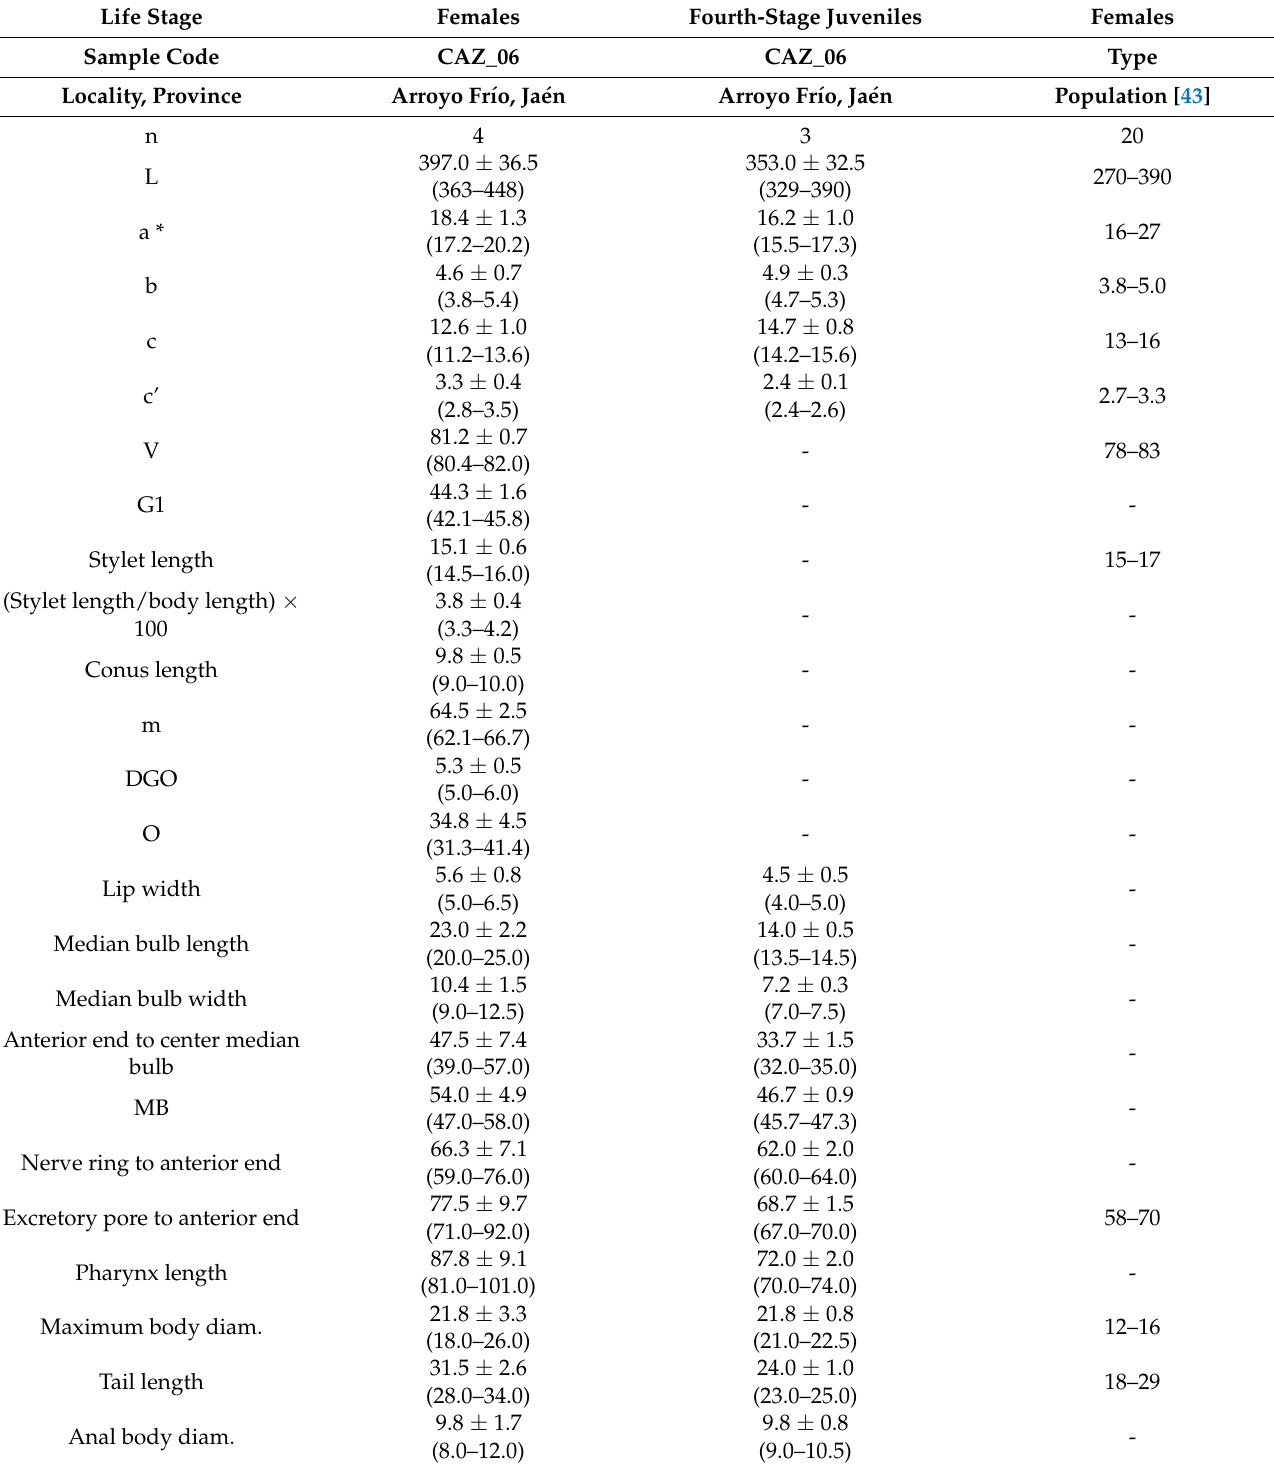
Table 9. Morphometrics of Paratylenchus recisus Siddiqi, 1996 from Arroyo Fr í o, Ja é n, Spain. All measurements are in µ m and in the form: mean ± s.d.